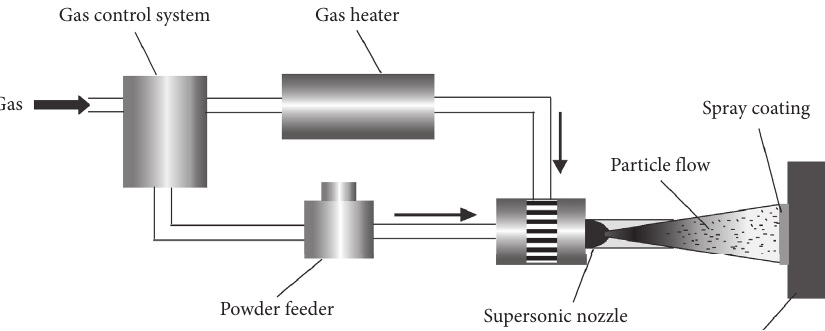
Figure 2: Principle diagram of cold spraying